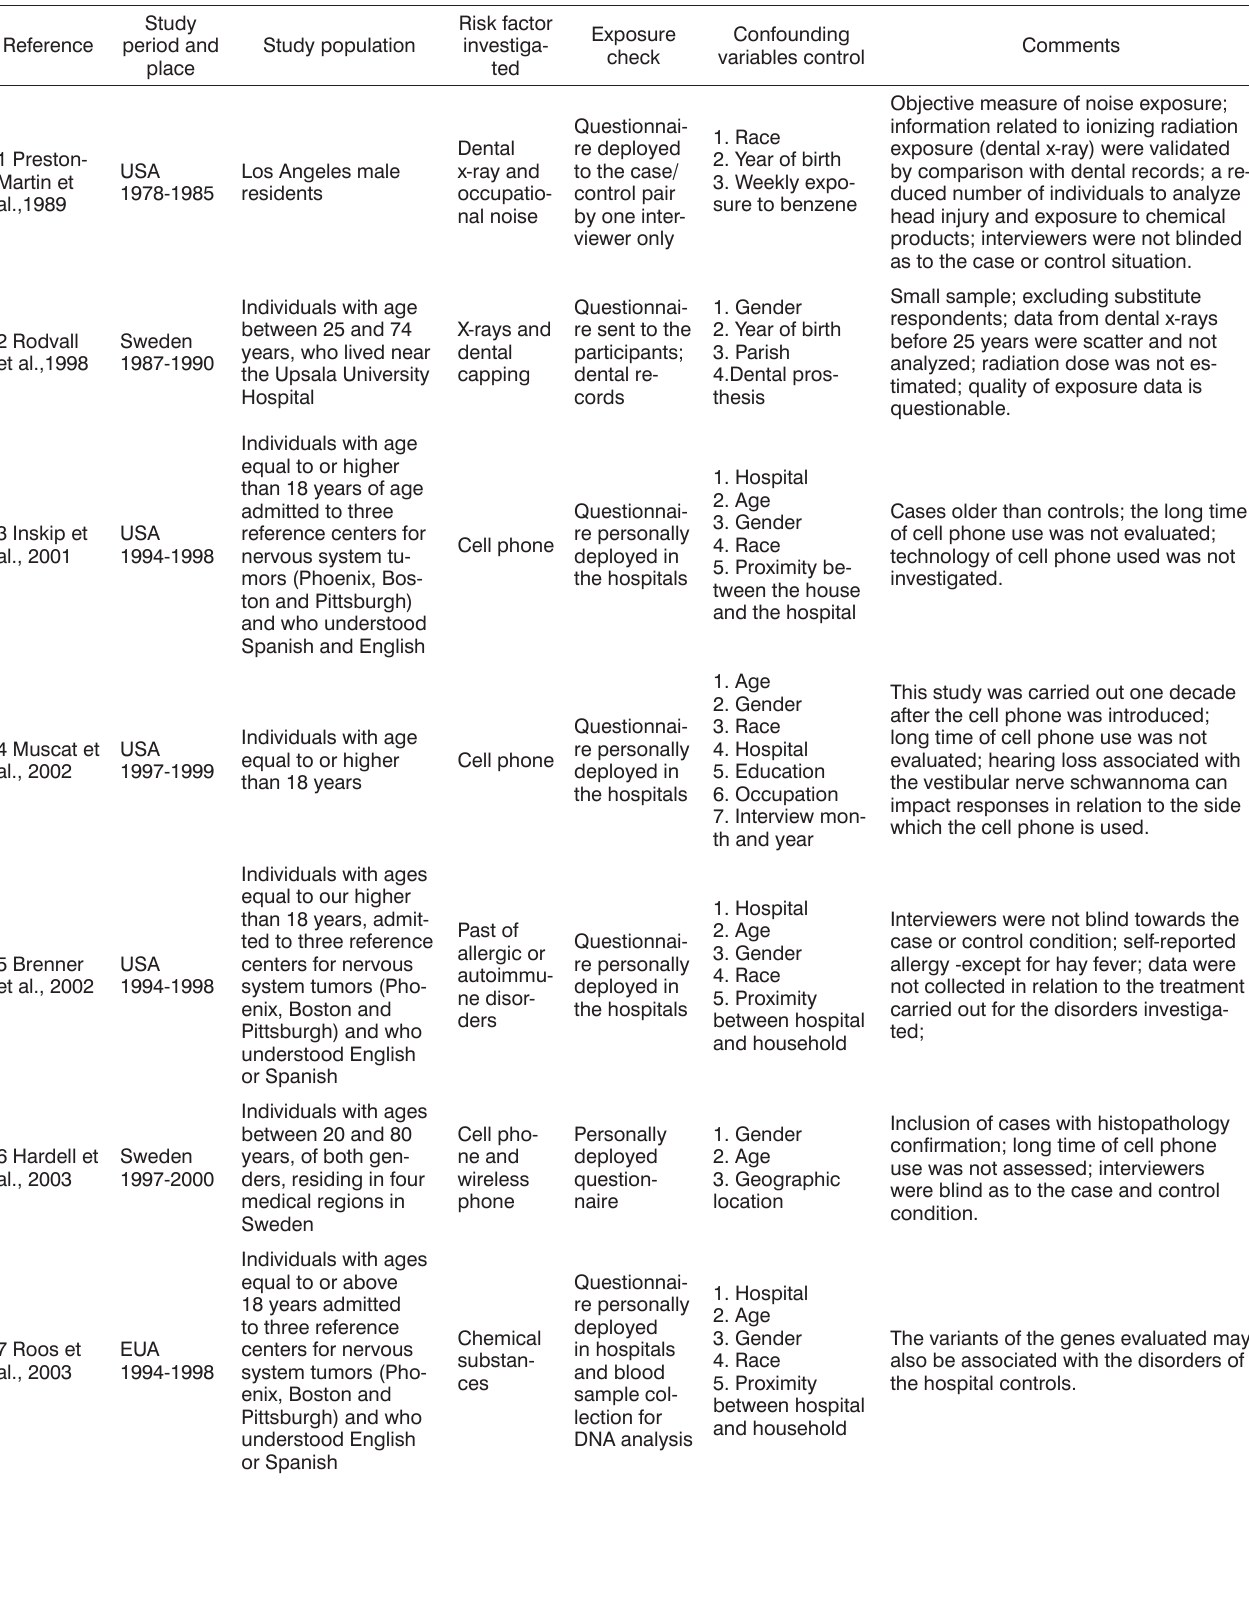
Table 1. Methodological characteristics of the studies which analyzed risk factors associated with vestibular nerve schwannoma